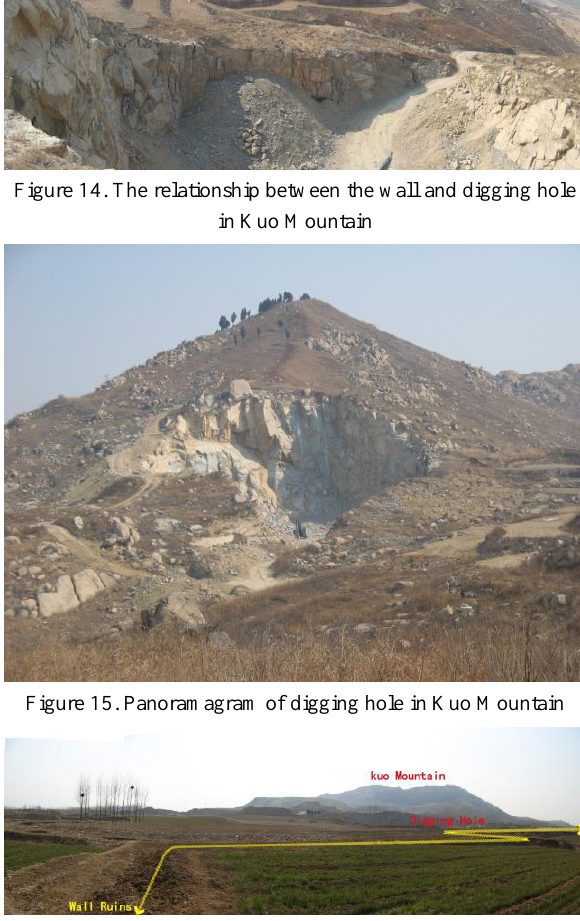
Figure 16. The relationship between the southeast corner of the wall and digging